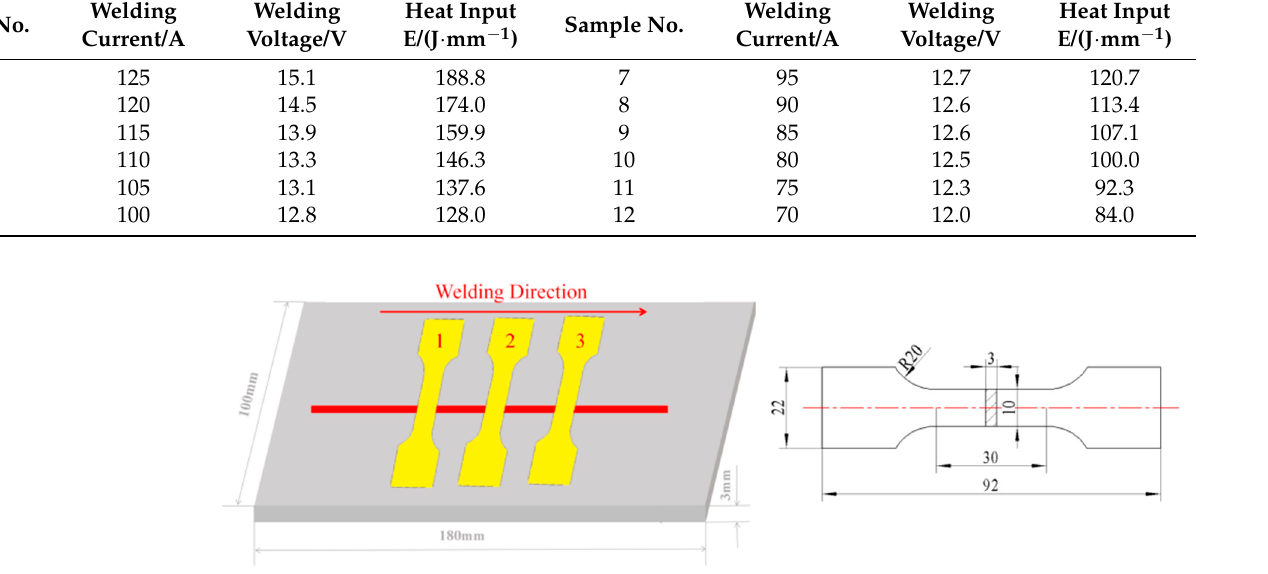
Figure 2. Tensile direction and size of tensile parts.